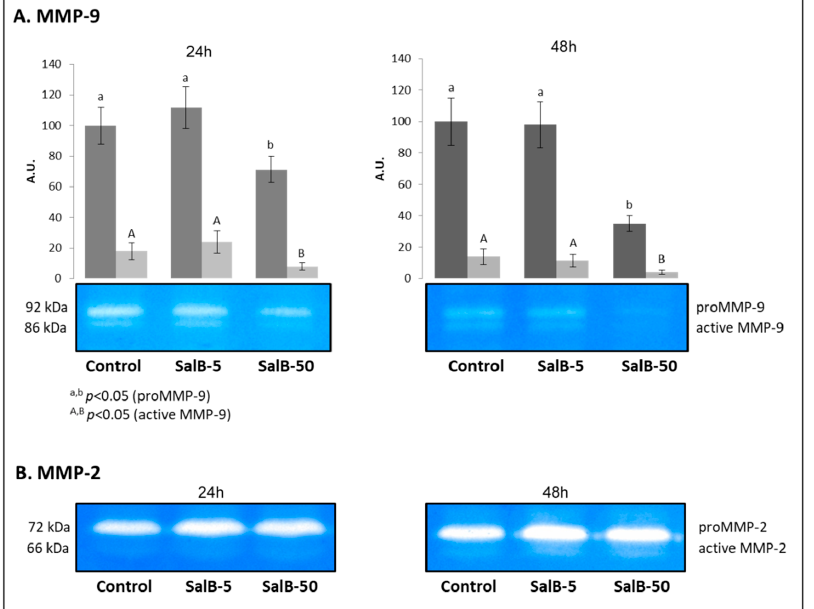
Figure 4. Gelatin Zymography for the evaluation of MMP-9 and MMP-2 activity. Zymographic evaluation of MMP-9 ( A ) and MMP-2 ( B ) activity in conditioned media obtained from MDA-MB-231 cells treated for 24 h and 48 h with SalB 5 and 50 µM.